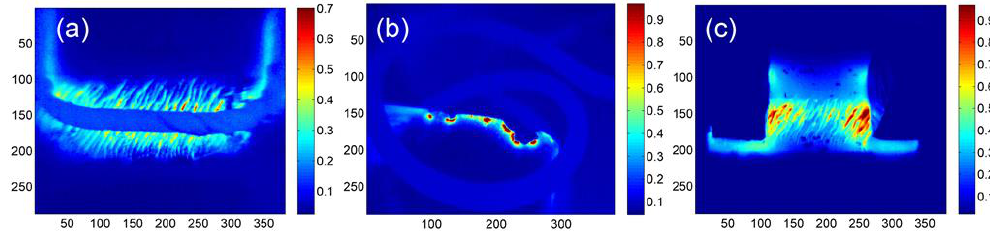
Figure 9. Experimental results of ECPT with different configurations. ( a ) Line-coil for multiple cracks. ( b ) Helmholtz-coil for crack edges and ( c ) Ferrite-yoke excitation for multiple cracks.